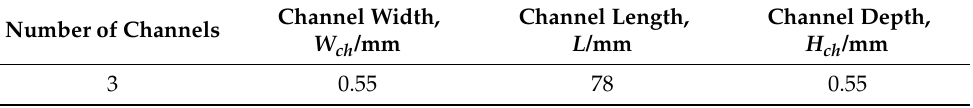
Figure 1. The schematic diagram of the experimental devices. 1, Reservoir; 2, filter; 3, micropump; 4, flowmeter; 5, pre-heater; 6, test-section; 7, camera; 8, differential pressure transmitter; 9, plate heat exchanger; 10, water cooling system; 11-1~11-6, valves; 12, AC power source. In the test-section, copper is used as the heating substrate for the microchannels, and three rectangular microchannels with a hydraulic diameter of 0.55 mm are processed on the top. The channel parameters are shown in Table 1. Figure 2 shows the construction and details of the test-section. Table 1. The channel